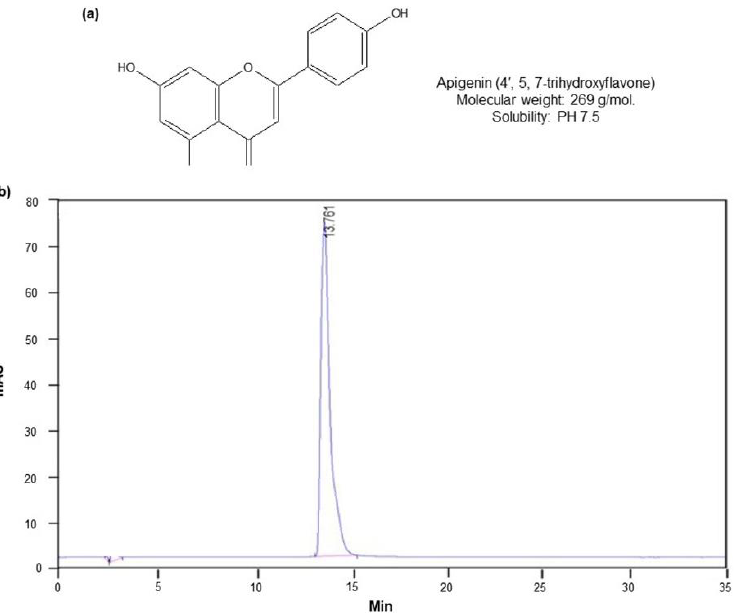
Figure 1. HPLC fingerprint of apigenin isolated from C. crispus . ( a ) Chemical name and structure of apigenin. ( b ) HPLC fingerprint of apigenin.